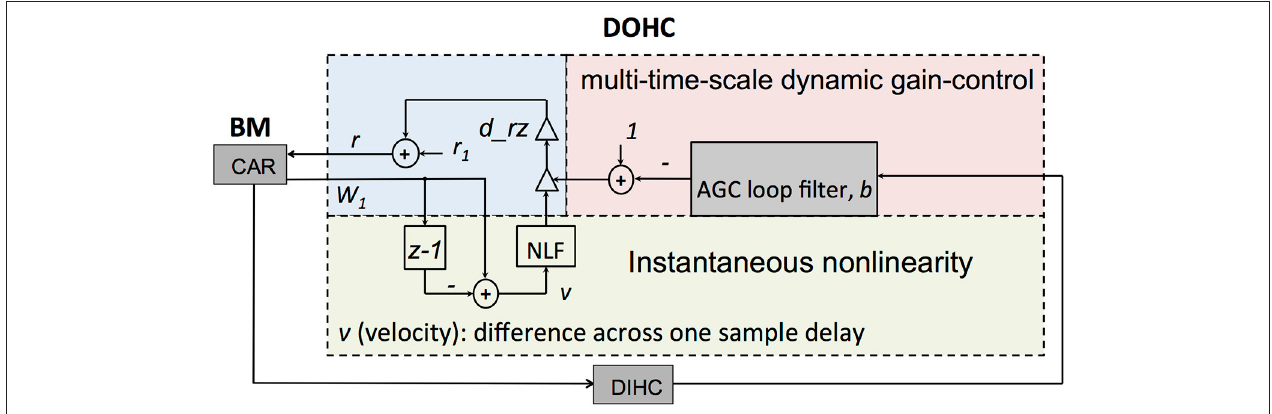
FIGURE 4 | Structure of the DOHC model. The instantaneous nonlinearity performs a nonlinear gain control (NLF) on the CAR velocity, which is calculated from the BM coefficient W